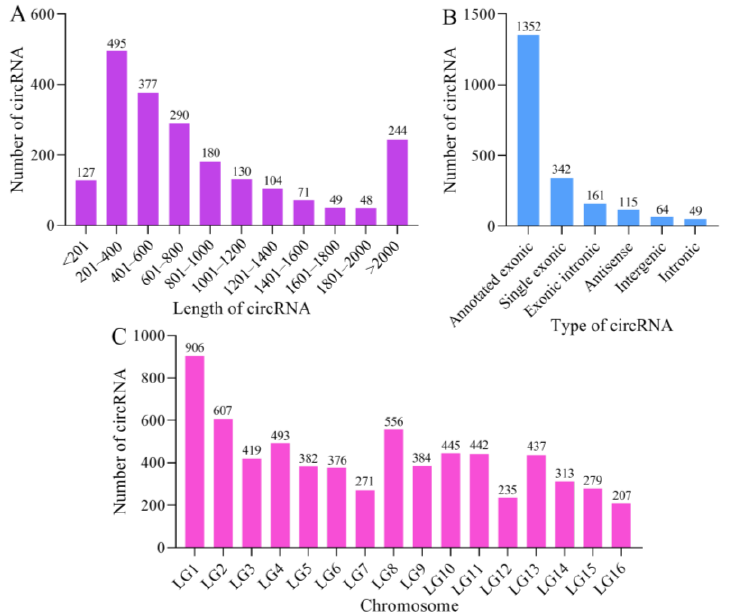
Figure 1. Characteristics of the identified A. m. ligustica circRNAs: ( A ) length distribution of circRNAs; ( B ) type distribution of circRNAs; ( C ) chromosomes enriched by